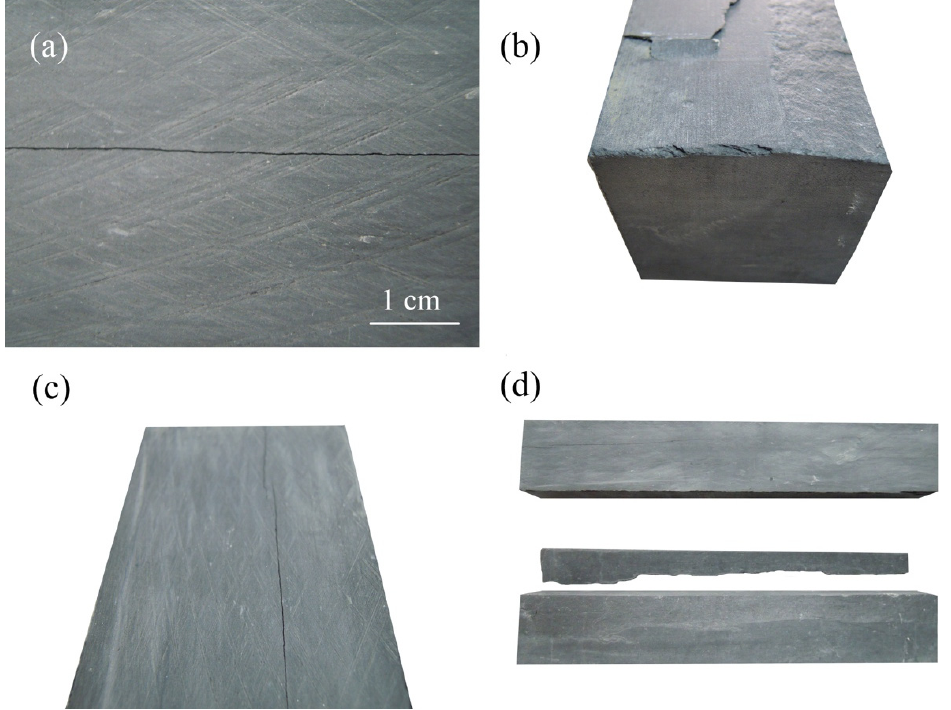
Figure 6. Slate damaging after aging: ( a , c ) S1 fractures due to volumetric expansion of the ice oriented parallel to the S0 slaty cleavage; ( b , d ) decay by spalling and exfoliation .